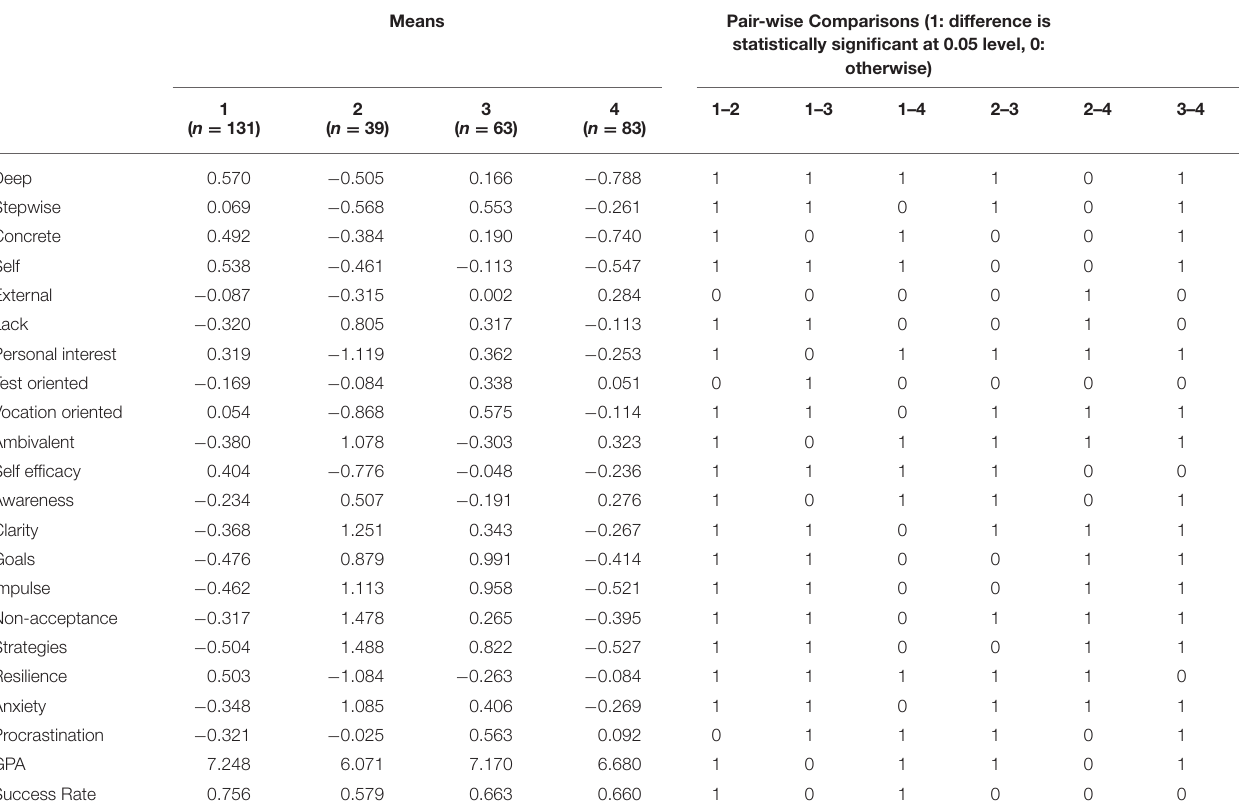
TABLE 4 | Cluster solution and multiple pair-wise comparisons. Means Pair-wise Comparisons (1: difference is statistically significant at 0.05 level, 0: